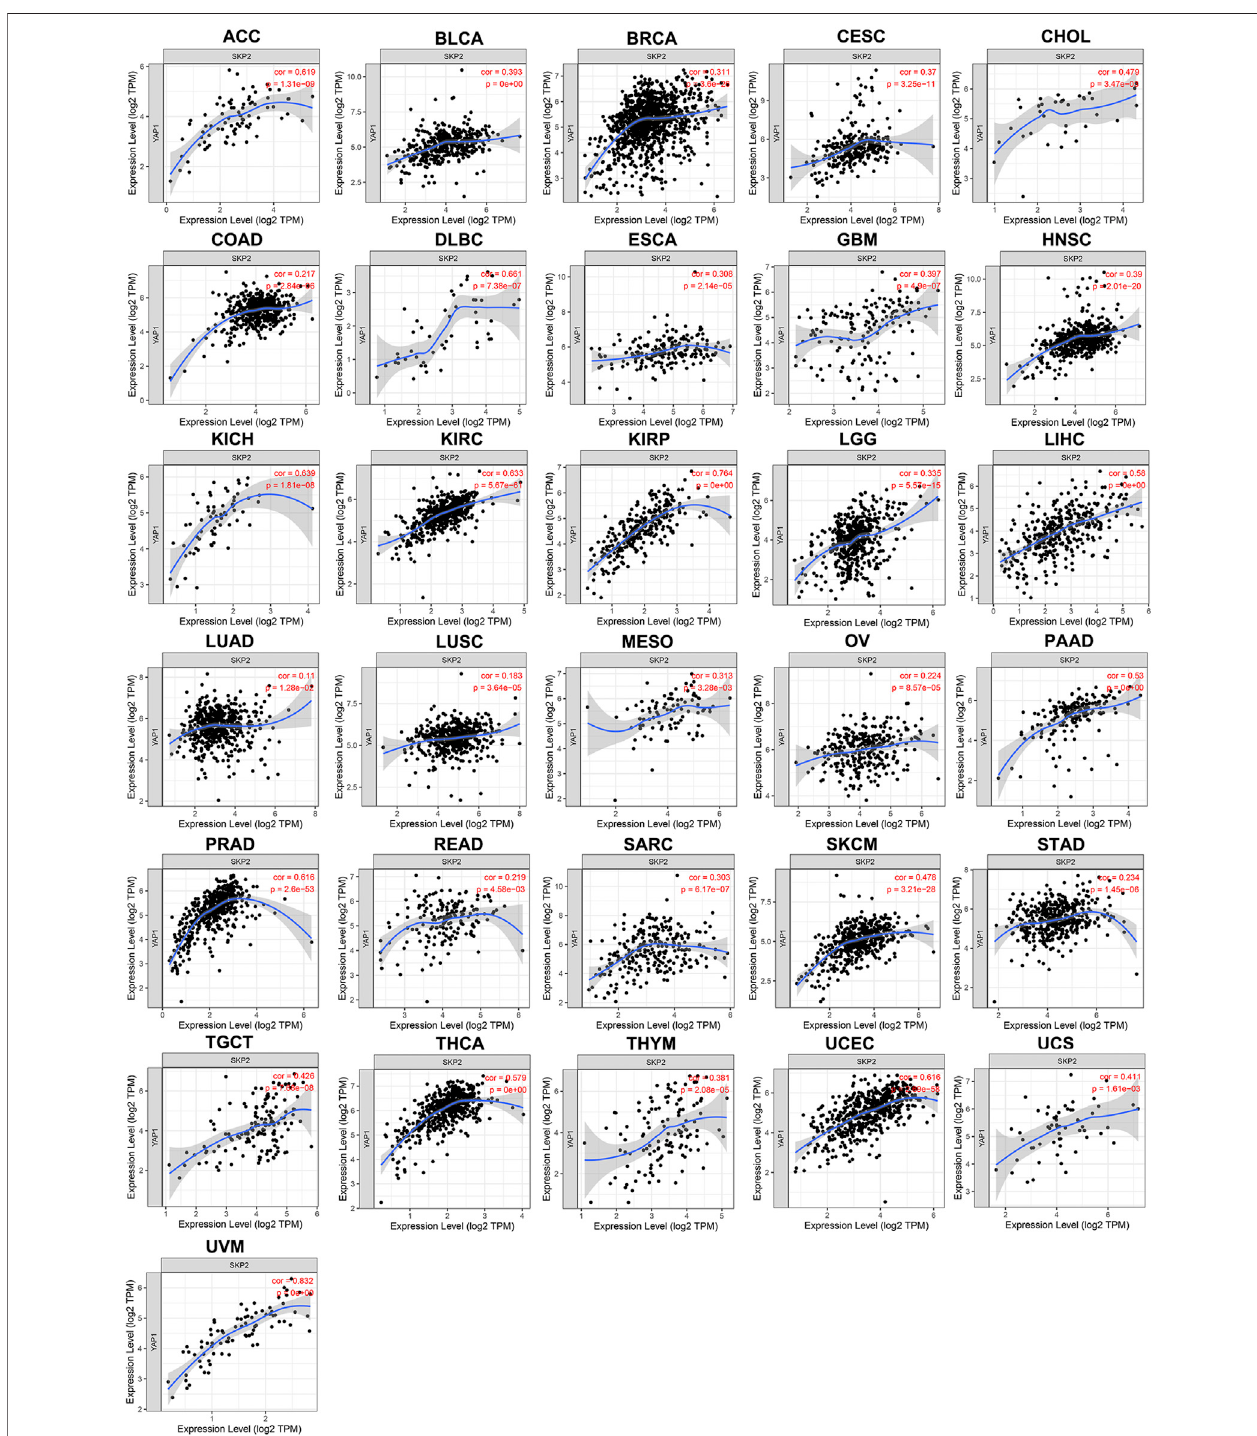
FIGURE 6 | The positive correlation between YAP1 and SKP2 expression analyzed by TIMER in pan-cancer.